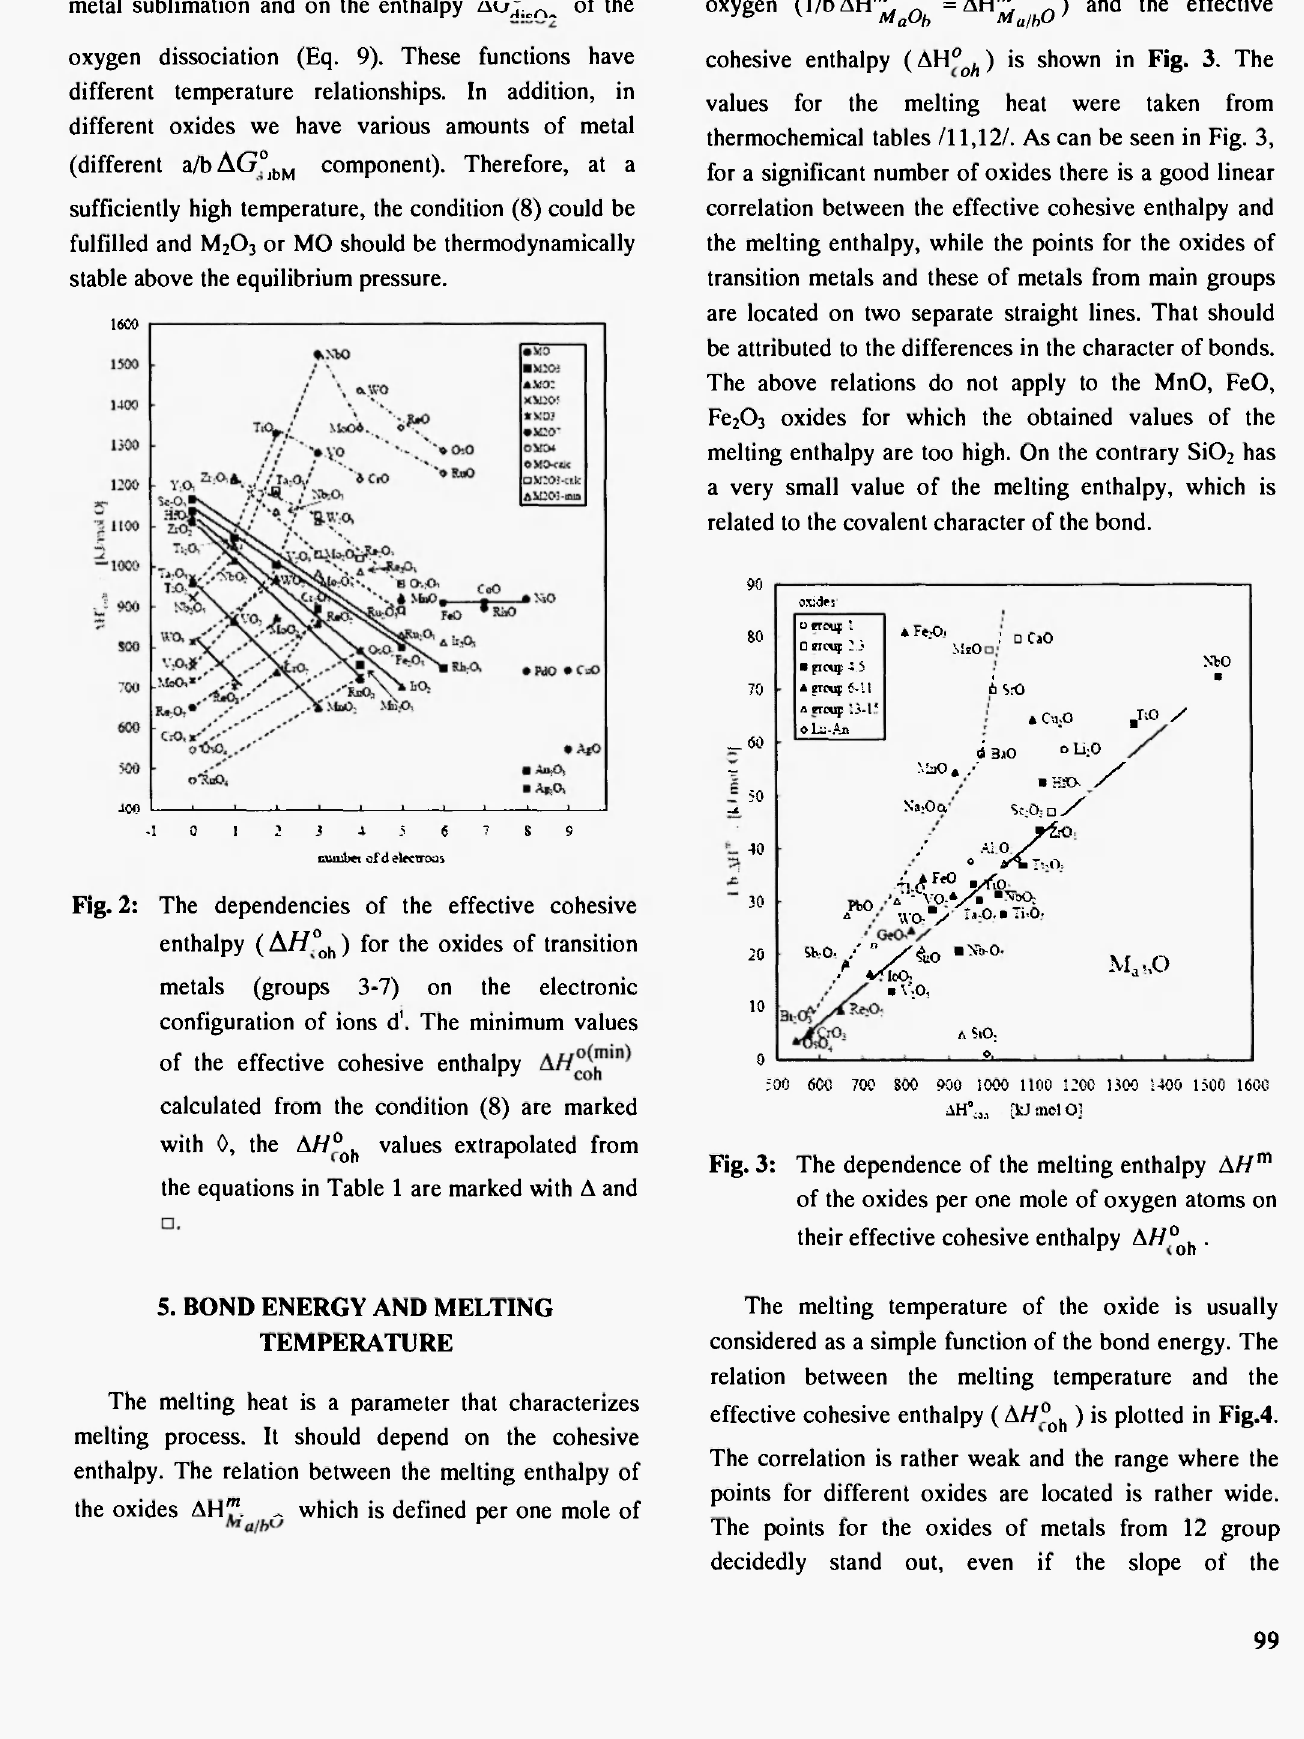
Fig. 2: The dependencies of the effective cohesive enthalpy (A//° oh ) for the oxides of transition metals (groups 3-7) on the electronic configuration of ions d 1 . The minimum values of the effective cohesive enthalpy calculated from the condition (8) are marked with 0, the Δ//° ο|) values extrapolated from the equations in Table 1 are marked with Δ and